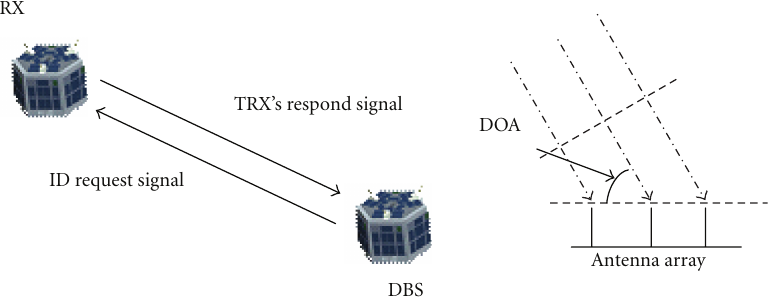
Figure 1: WLPS signal transmission between DBS and